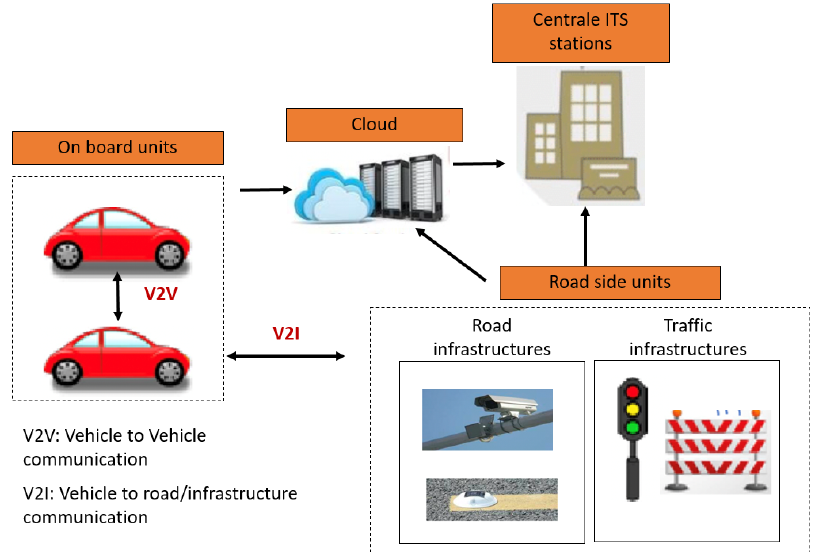
Figure 1. Architecture for ITS.